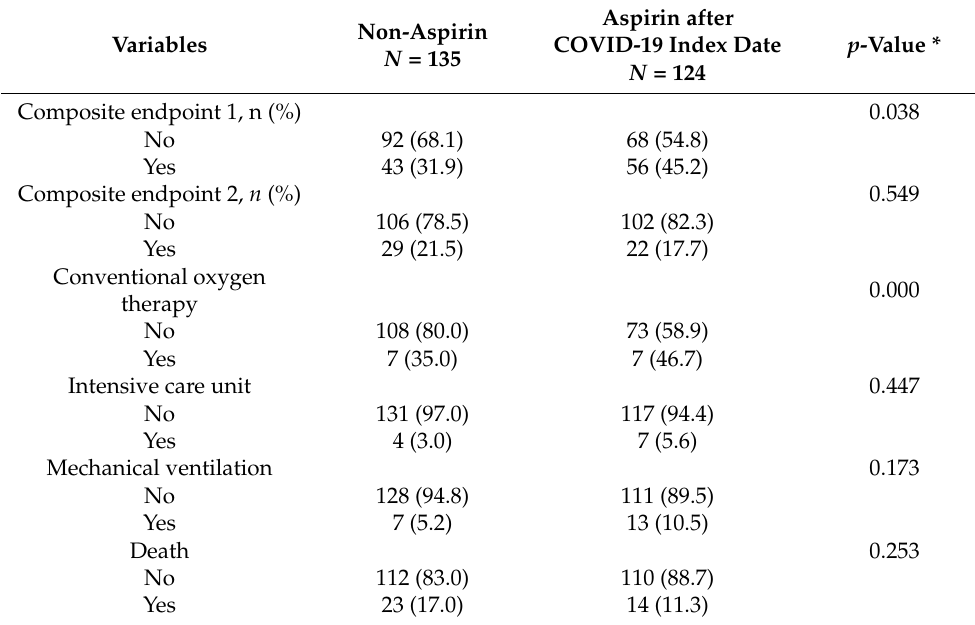
Table 5. Clinical outcomes of COVID-19 between non-aspirin and aspirin users after